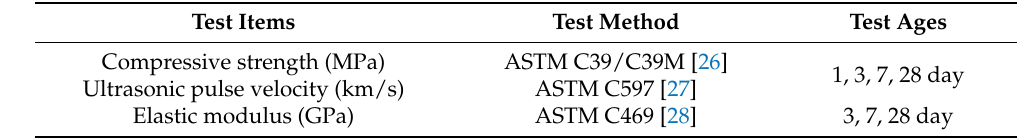
Table 6. Testing methods used for determining the mechanical